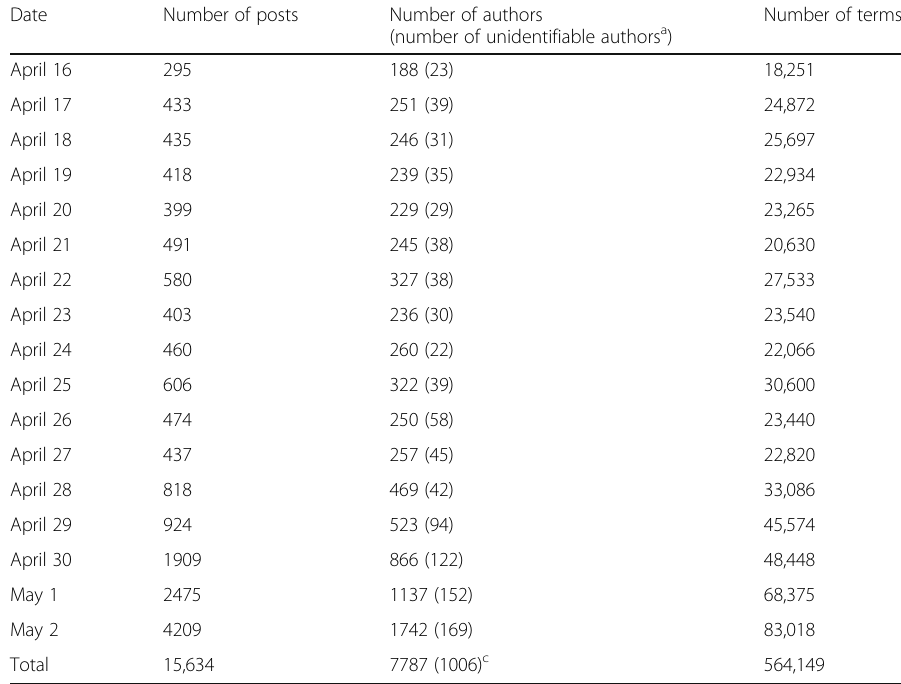
Table 1 Profile of the collection of digital